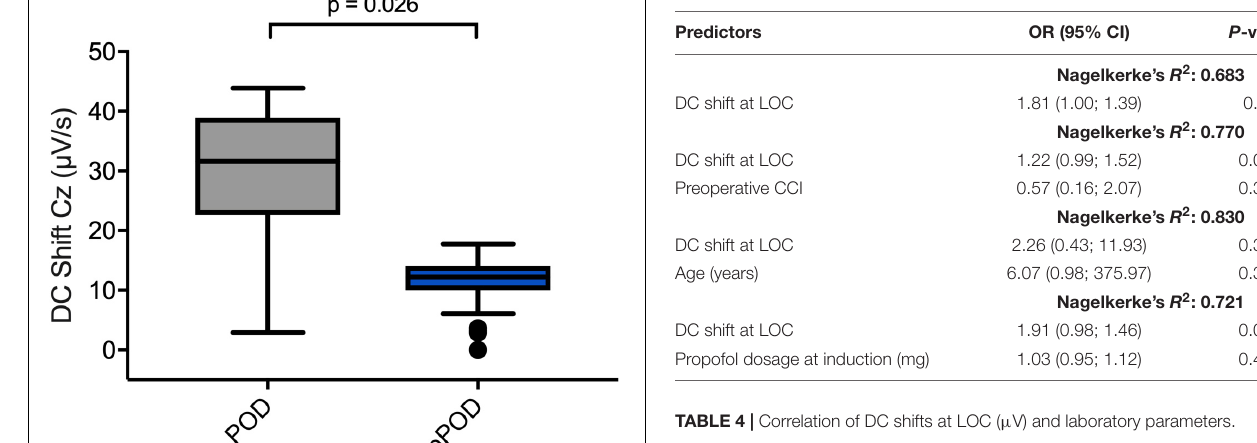
TABLE 3 | Logistic regression models.